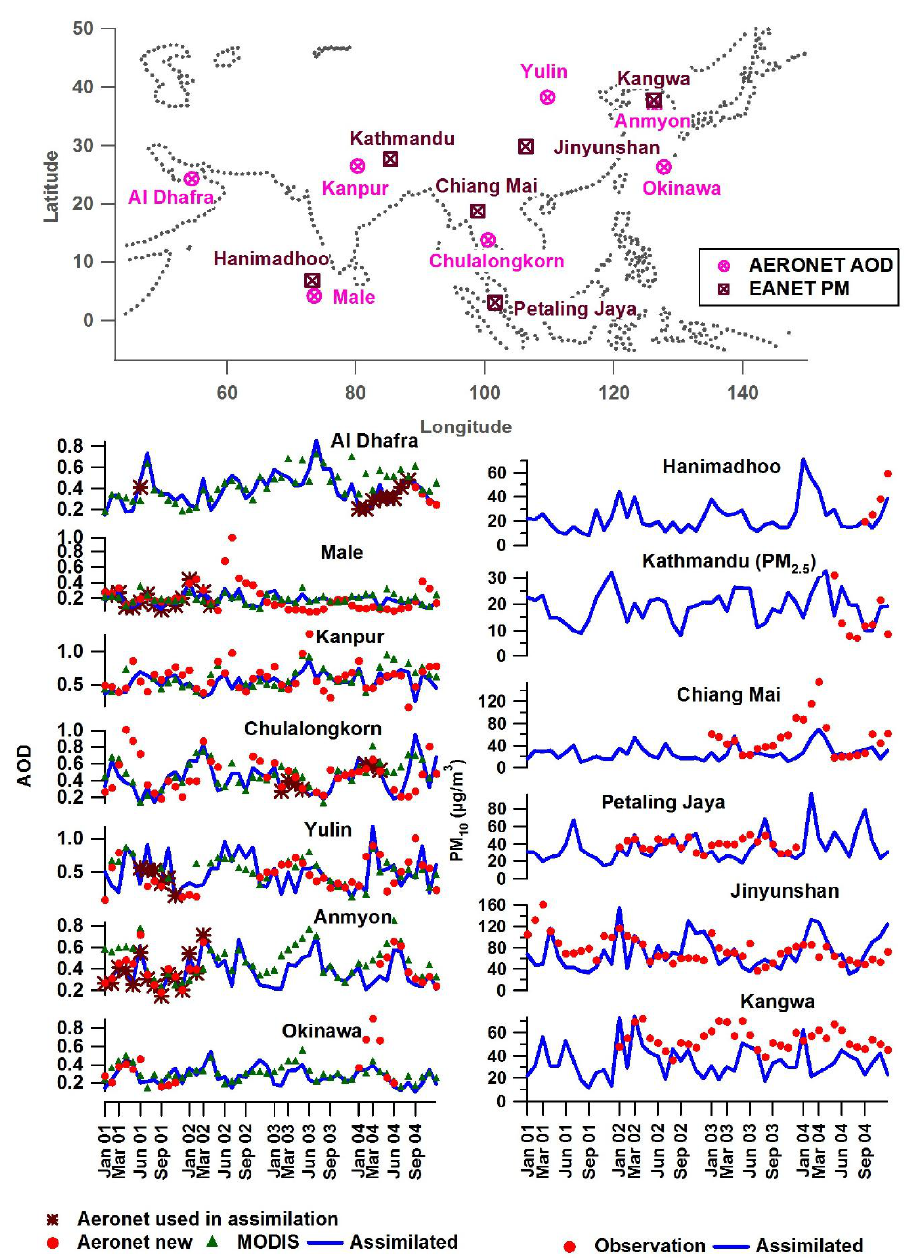
Fig. 5. AOD (left panels) and surface PM 10 mass concentration (right panels). Modeled AOD and PM10 concentration after assimilation, in comparison with MODIS and AERONET AODs and EANET PM10 observations at selected sites. The AERONET AODs used in the assimilation are also shown. The AERONET new denotes the AOD values used for evaluation of the model prediction skills. Further details of the “AERONET new” are described in the text.